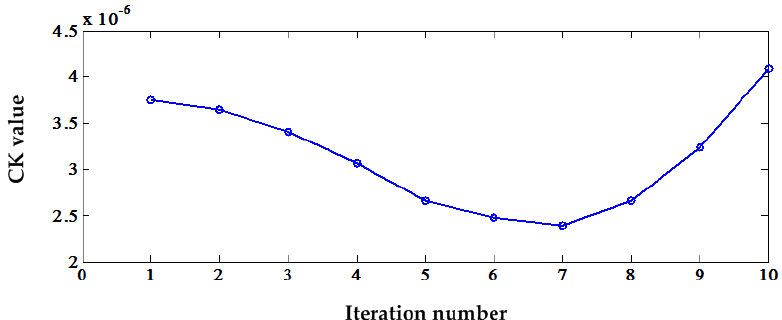
Figure 25. CK value variation vs. iteration number.